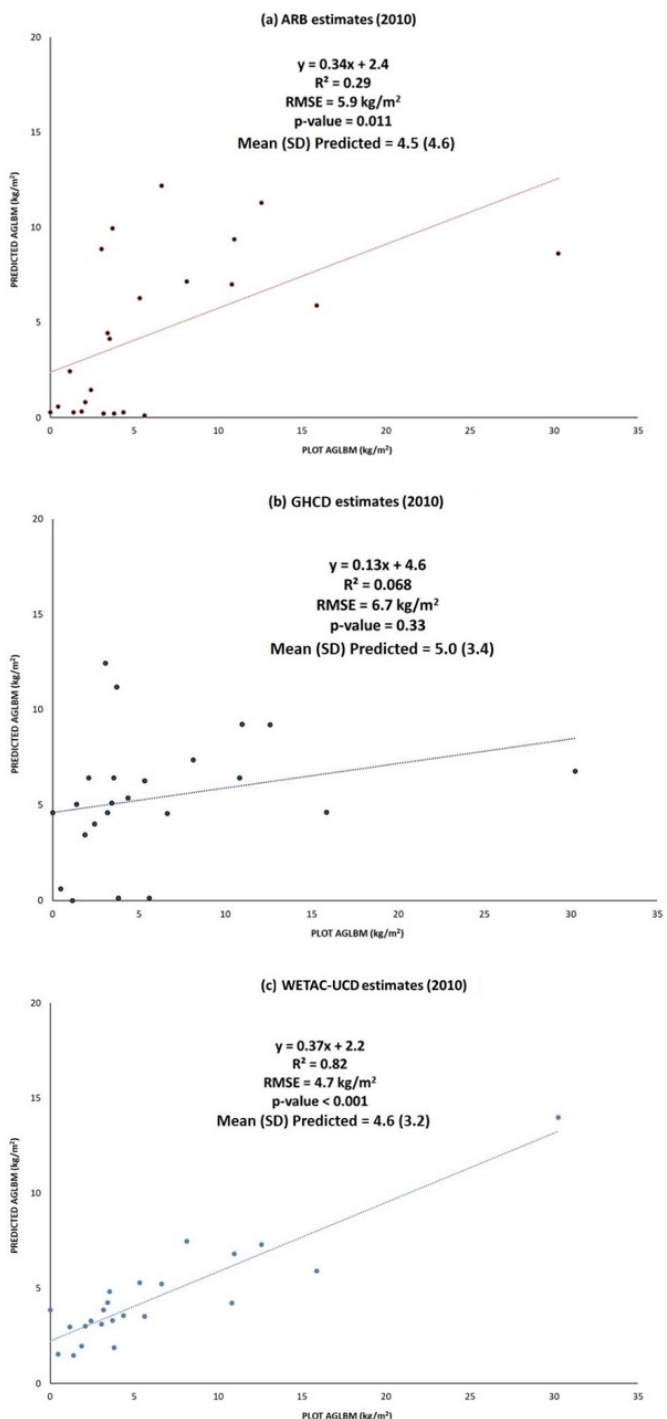
Figure 3. ( a ) Aboveground live biomass (AGLBM) estimates from the California Air Resources Board (ARB) [65] versus field plot estimates; ( b ) AGLBM estimates from the University of Wisconsin-Madison (GHCD) [60] versus field plot estimates; ( c ) AGLBM estimates from this study (WETAC-UCD) versus field plot estimates. The ARB and ORNL estimates were for the year 2010; therefore, we only used the 22 validation plots that were visited in 2010 for this analysis.